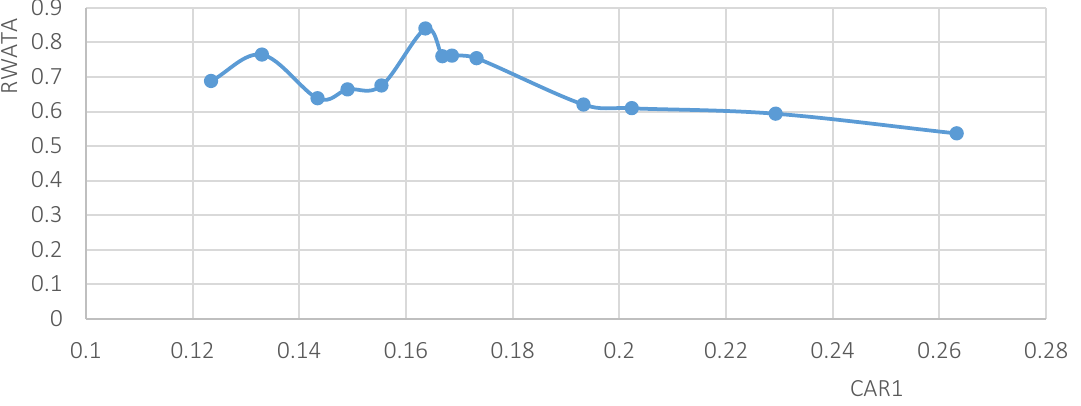
Figure 4. Capital adequacy ratio (CAR1) and total risk